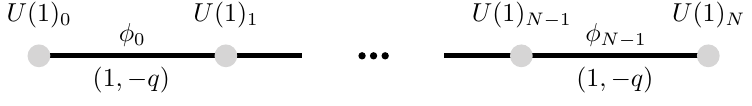
Figure 1 . Quiver diagram for the vector clockwork construction. Circles denote U(1) gauge groups, and lines represent complex scalar (cid:12)elds charged under adjacent